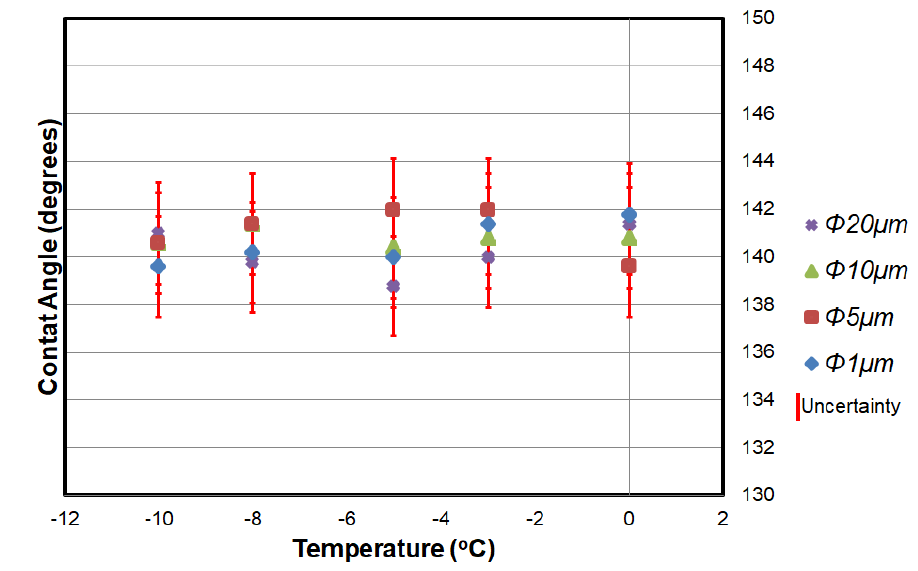
Figure 7. Static-evaluation results related to the